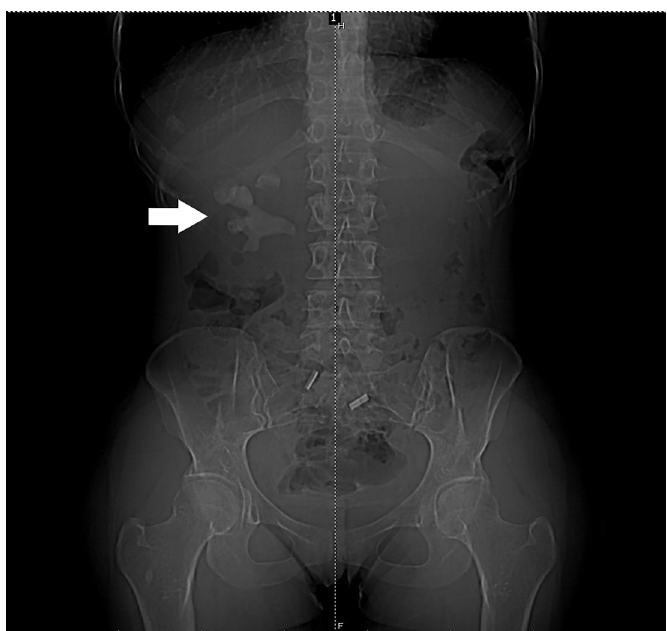
Image 1. Computed tomography scout image demonstrating large staghorn calculus